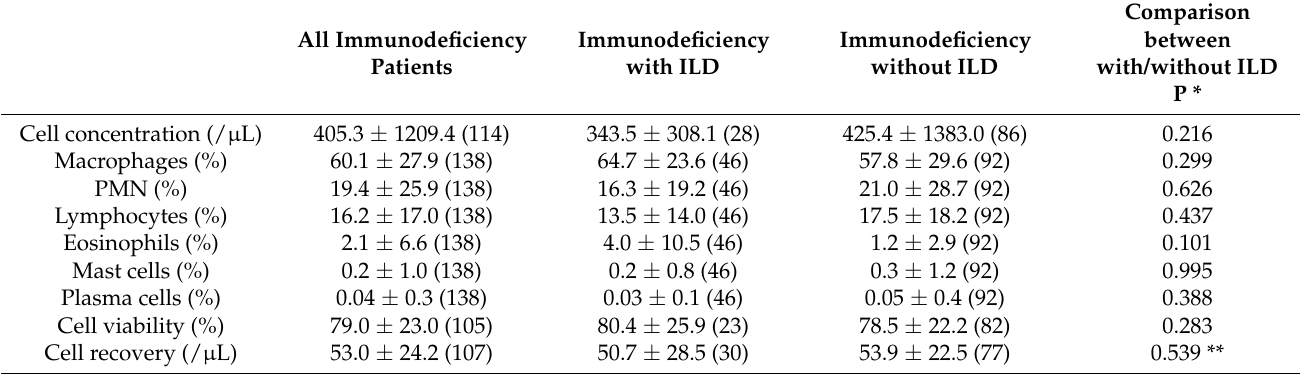
Table 3. Features of ILDs in immunodeficient children.